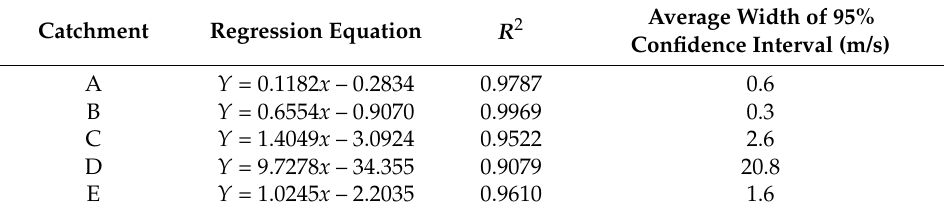
Table 3. Results of regression analysis between peak rainfall and peak runoff in urban catchments.